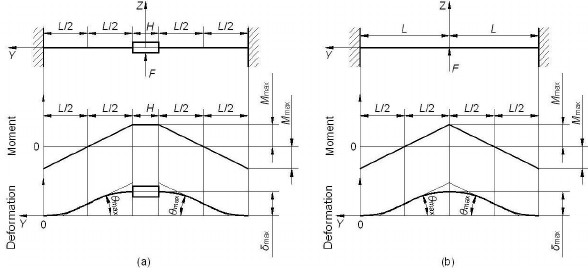
Figure 4. The moment, the deformation, and the rotated angle of Figure 4: The moment, the deformation, and the rotated angle of the CM from (a) conceptual design and (b) simplified design. The maximum moment M max , the maximum deformation δ max , and the the CM from (a) conceptual design and (b) simplified design. The maximum rotated angle θ max of the CM are also displayed. maximum moment M max , the maximum deformation δ max , and the maximum rotated angle θ max of the CM are also